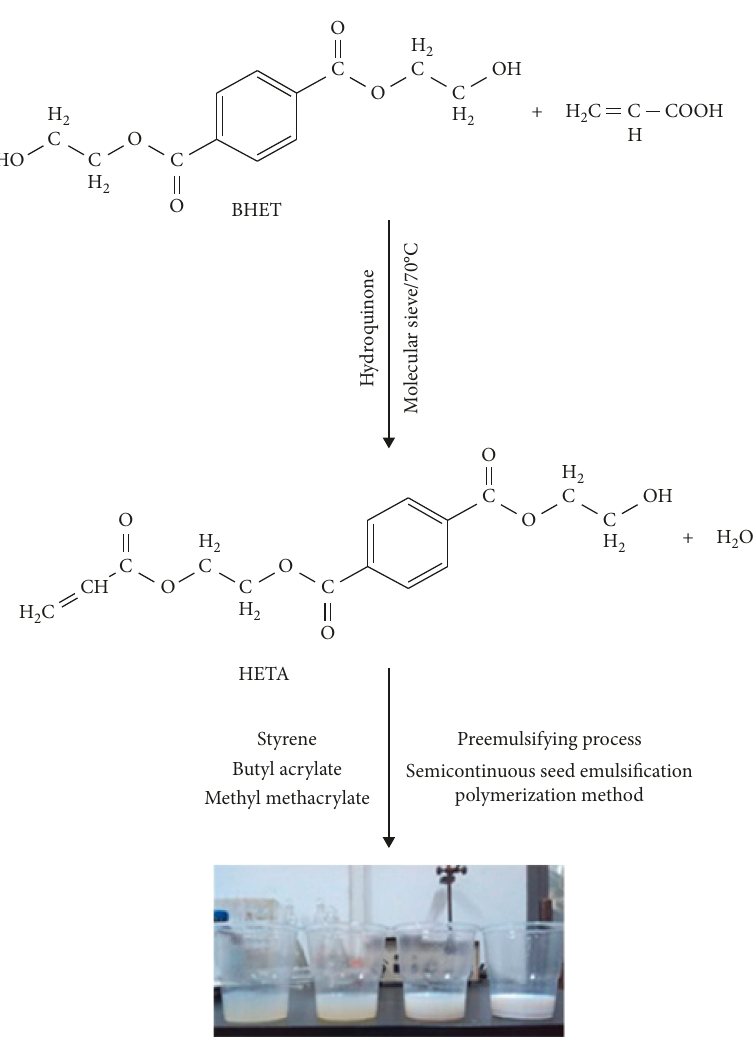
Figure 3: Synthesis route of the modified styrene-acrylic